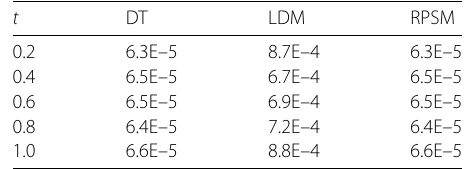
Table 4 Comparison of computing time for u 1